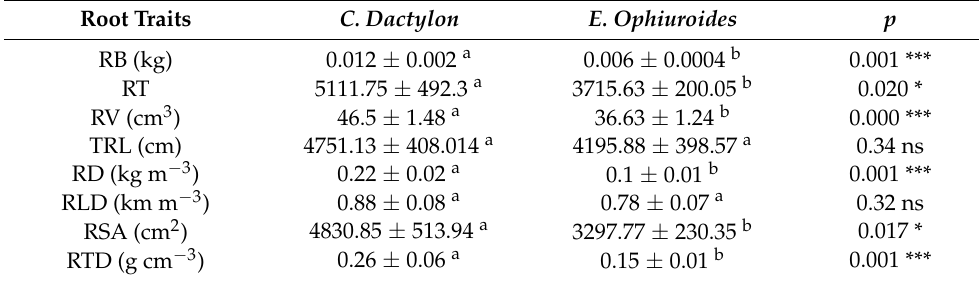
Table 2. Means ± SEs of root traits for C. dactylon and E. ophiuroides . Root